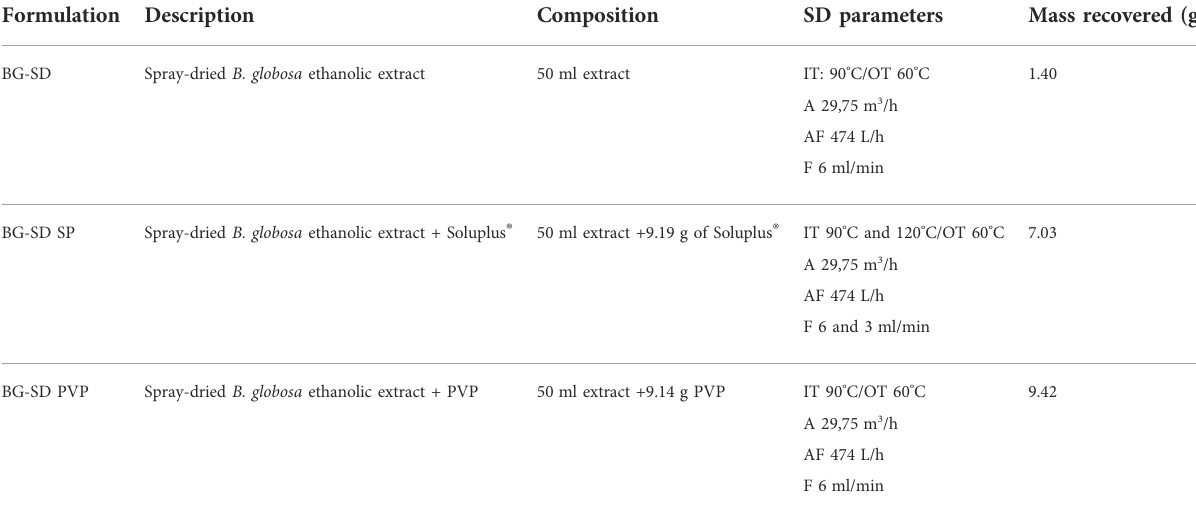
TABLE 1 BG formulations studied and prepared by spray drying. Formulation